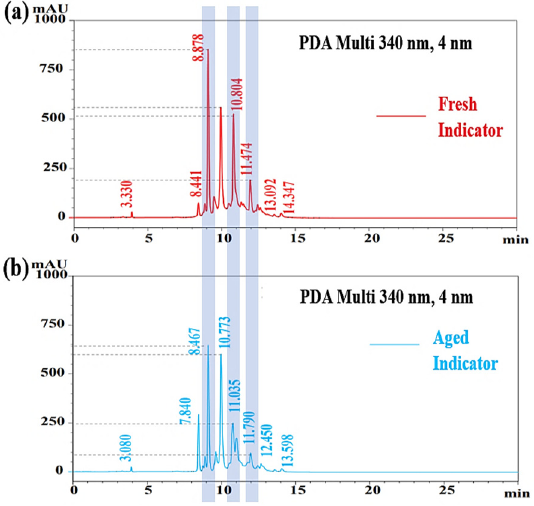
Figure 5. Chromatograms of ( a ) fresh and ( b ) aged F. orchid indicators.